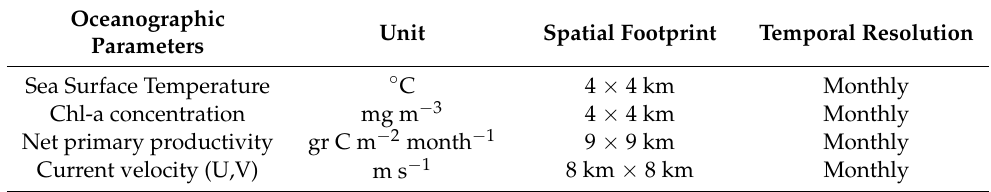
Table 1. List of remotely sensed satellite data used to define mature skipjack tuna habitat hotspots. Oceanographic Unit Spatial Footprint Temporal Parameters